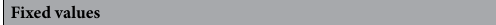
Table 3. Numeric results of skin friction and heat transfer coefficient under influence of stretching ratio and non linearity effect.